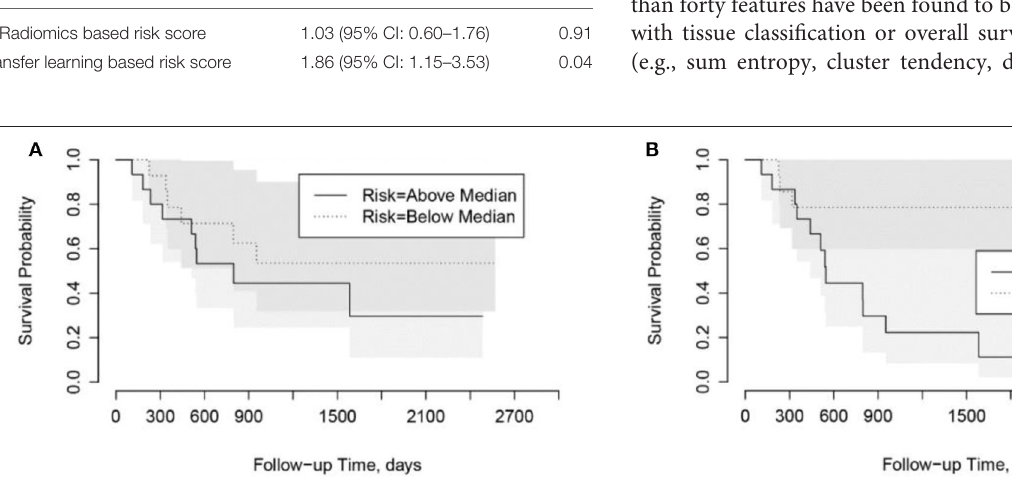
FIGURE 5 | Kaplan-Meier plots for overall survival in Cohort 2. (A) PyRadiomics based risk score ( p = 0.91). (B) Transfer Learning (LungTrans) based risk score ( p = 0.04).